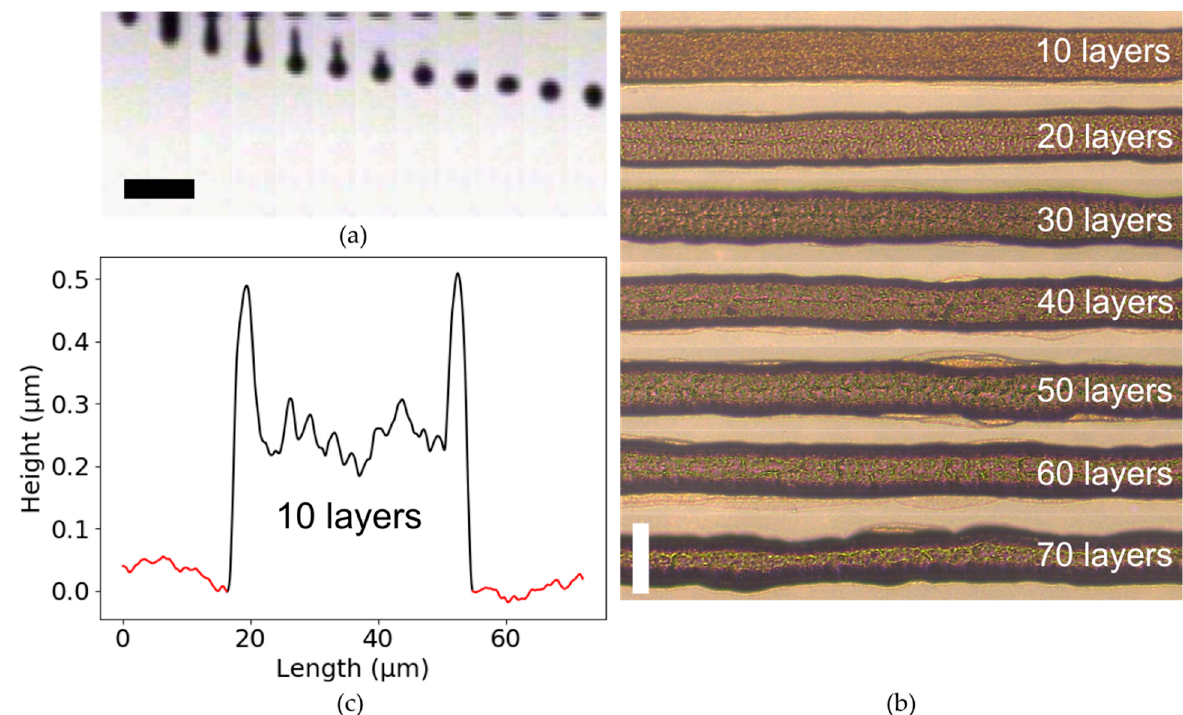
Figure 8. Droplet ejection sequence ( a ), printed lines in varying numbers of layers on a gloss photopaper ( b ), and the measured profile ( c ) of a highly loaded, sterically stabilized MGNS inks. The red lines of ( c ) indicate data that was excluded from cross-sectional area calculations. All scale bars indicate 50 µm.